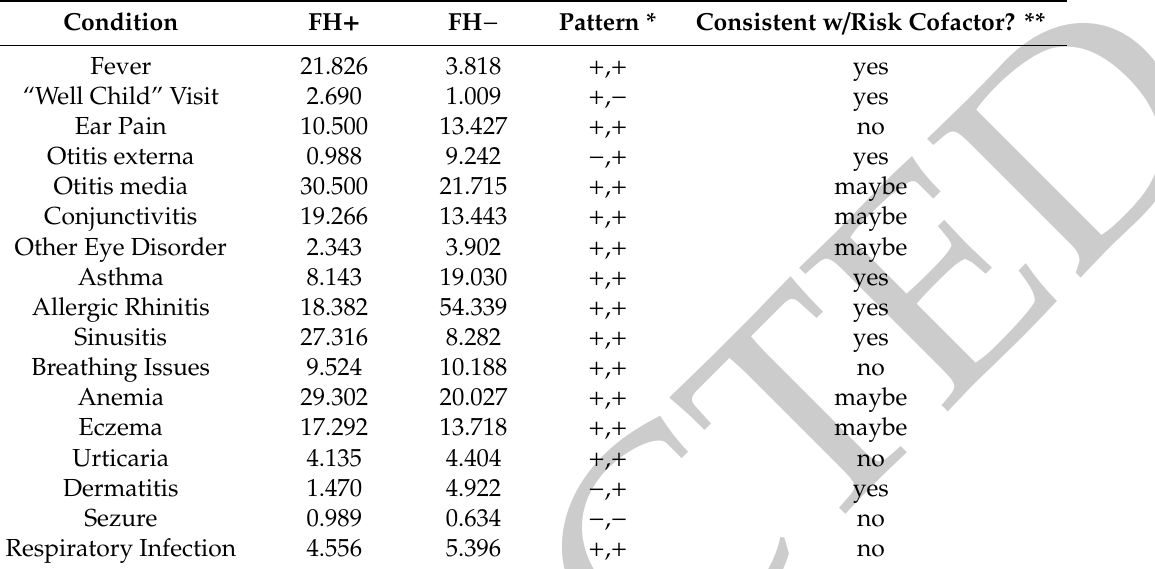
Table 6. RIOV score blocked by family history and implication for co-factor